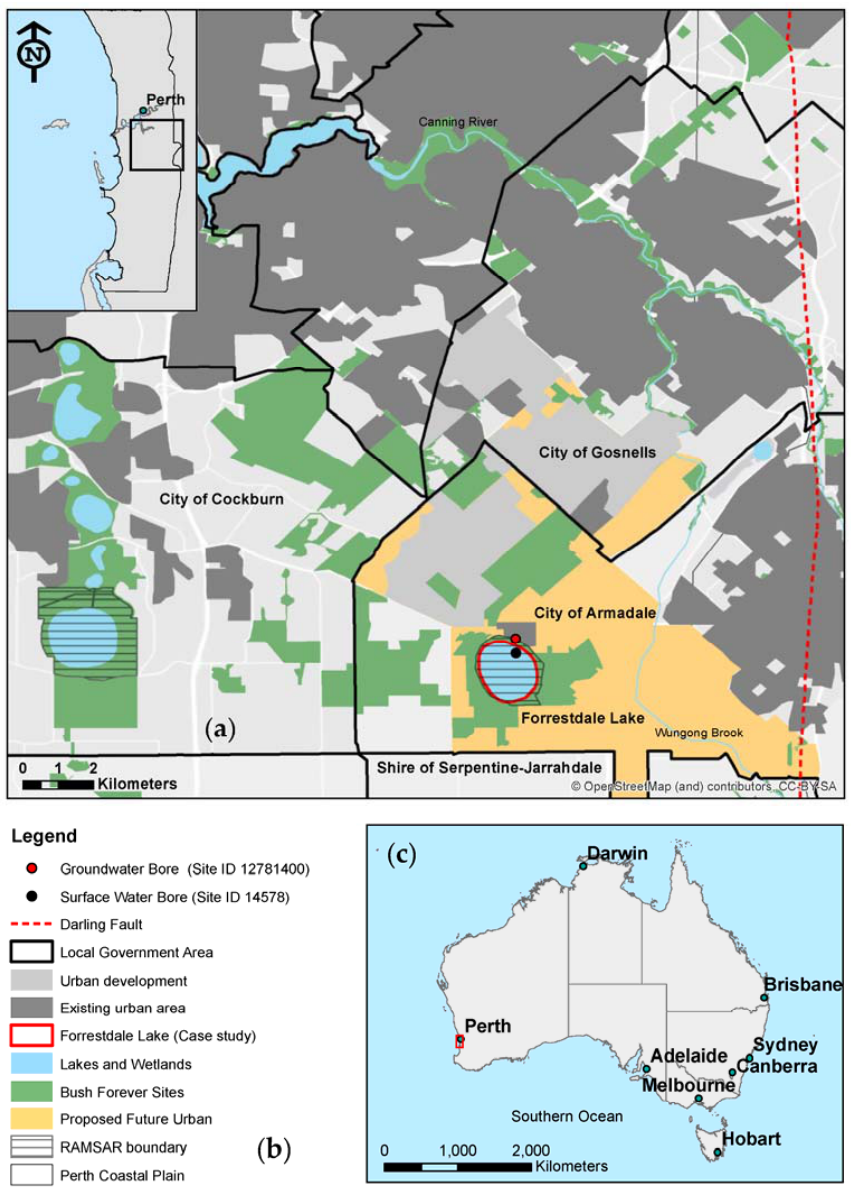
Figure 1. ( a ) Location of Forrestdale Lake (32°09 ′ 30” S, 115°56 ′ 16” E) with multiple management